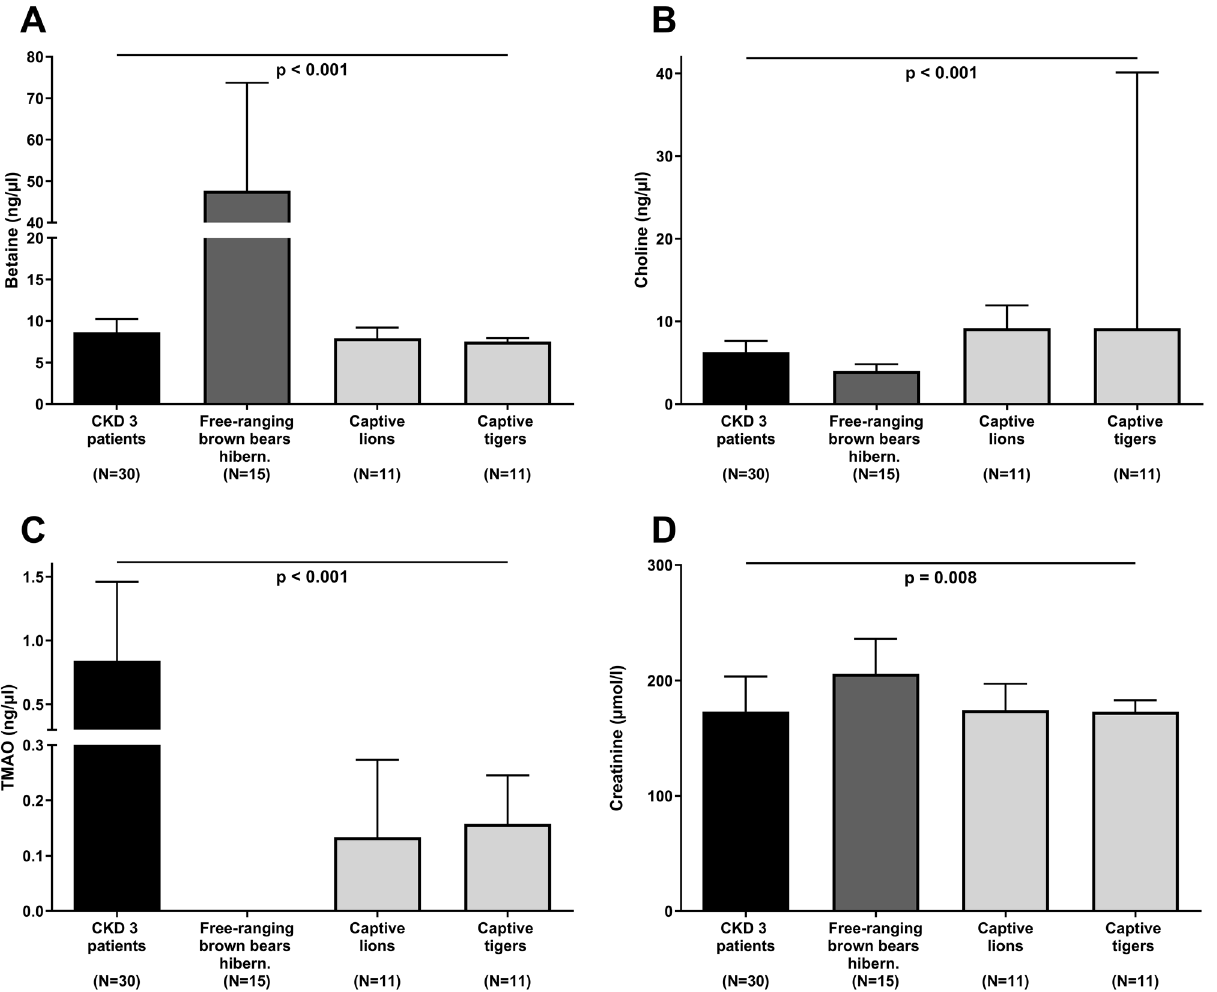
Figure 6. Circulating levels of ( A ) betaine, ( B ) choline, ( C ) trimethylamine N-oxide (TMAO), and ( D ) creatinine in human subjects with chronic kidney disease (CKD) stage 3 (black bars) compared to different animal species with a CKD-like status, i.e. free-ranging brown bears during hibernation (dark grey bars), as well as captive lions and tigers (light grey bars). Results are shown as median (interquartile range). Overall p values between the four groups were assessed by non-parametric Kruskal–Wallis test. Group-wise comparisons using Bonferroni post hoc analysis are described in the Results section. Number of subjects/animals included in each group is depicted. TMAO levels could not be detected in hibernating free-ranging brown